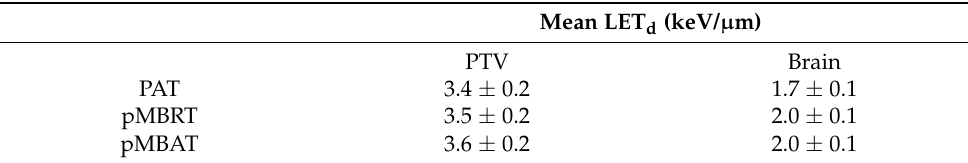
Table 3. Mean LET d in the PTV and brain volume.